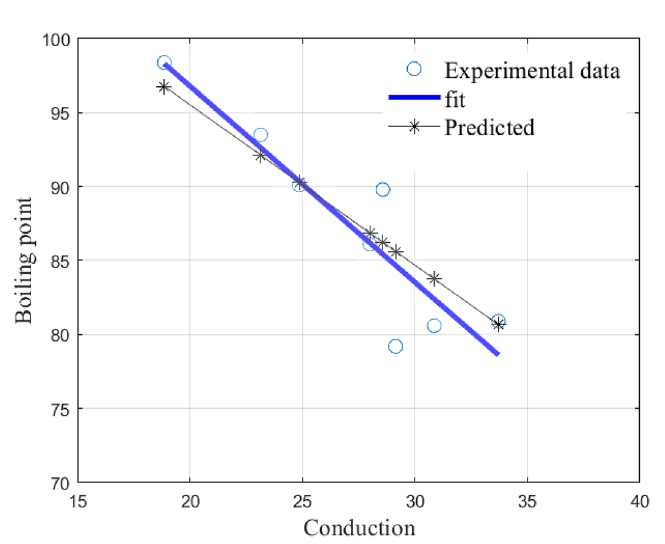
Figure 8. Shows a comparison of the linear least squares fit to experimental data and the linear model (8) for all alkanes of order